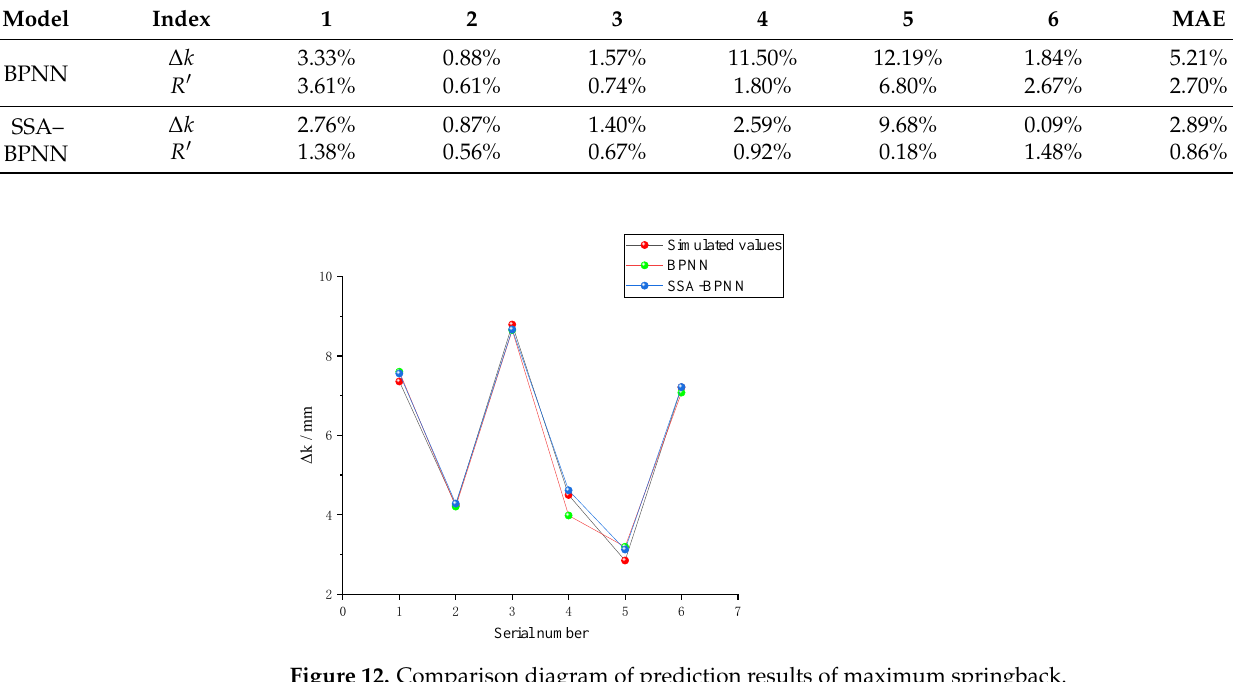
Figure 12. Comparison diagram of prediction results of maximum springback.